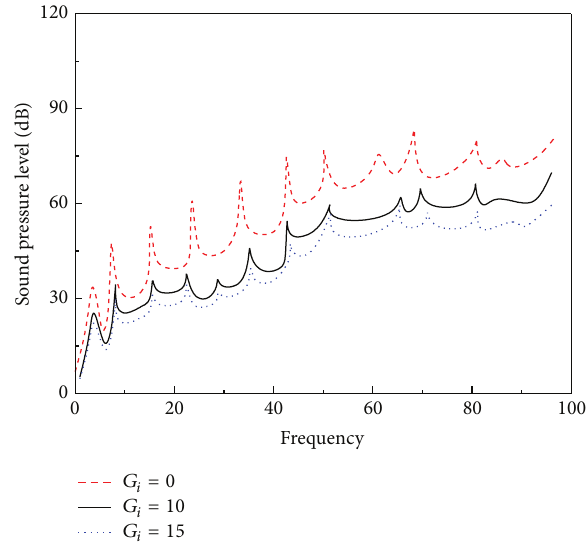
Figure 21: Sensed electric potential with feedback control loop under active control.